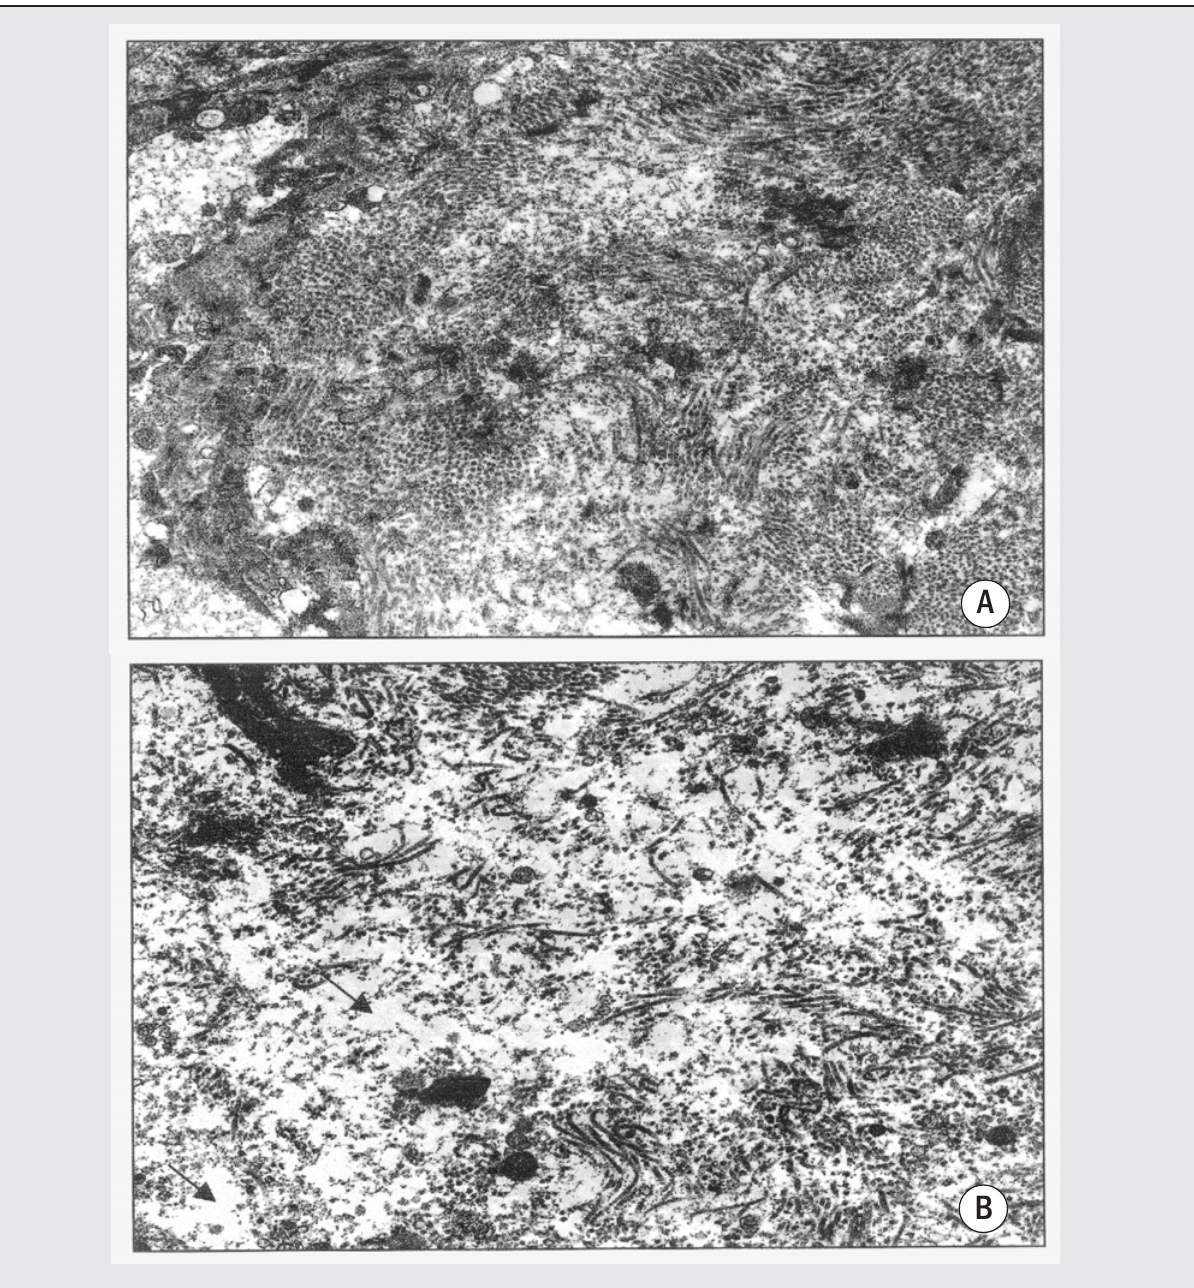
Figure 2 – Focal and extensive fragmentation of collagen fibrils, associated with the presence of dark deposits (focal electron dense change) and clear areas of rarefaction, observed in rats treated with carbon tetrachloride for 12 weeks, 2 weeks (A) and 12 weeks (B) after discontinuation of treatment. Electron micrograph, x